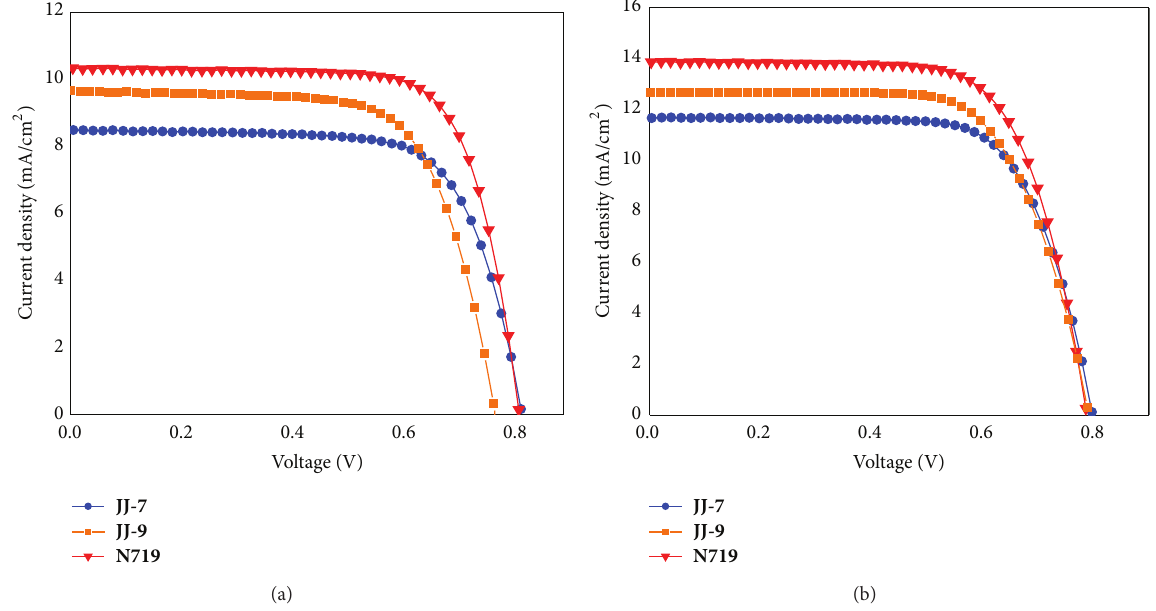
Figure 6: J-V curves of JJ-7 (blue line), JJ-9 (orange line), and N719 (red line) using (a) 5 𝜇 m TiO 2 film and (b) 10 𝜇 m TiO 2 film.